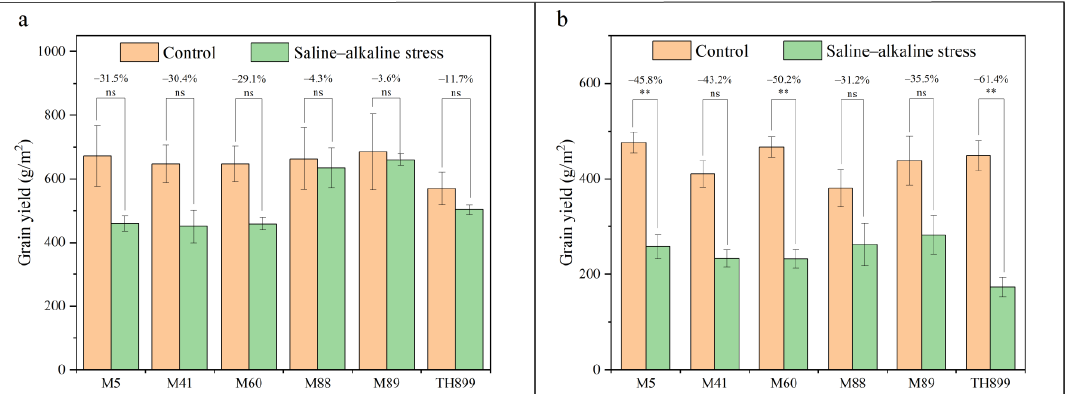
Figure 4. Grain yield of mutant lines and the parent TH899 under saline–alkaline stress and control condi- tions in 2019 ( a ) and 2020 ( b ). Bars are the means and standard errors of three ( a ) and four ( b ) replications. ** indicates significant differences at p < 0.01; and ns indicates no significant differences. The values on top of the bars indicate the decrease in grain yield under saline–alkaline stress relative to the control. In 2019, the ANOVA of the yield components of the mutant lines and TH899 under saline–alkaline stress revealed significant differences in SP and 1000-GW between the mutant lines and TH899. The SP and the 1000-GW were higher in mutant lines compared with TH899 (Table 4). In 2020, ANOVA of the yield components of the mutant lines and TH899 under saline–alkaline stress revealed significant differences in PH, PL, and 1000-GW between the mutant lines and TH899. The PH was shorter (84.8 cm to 95.0 cm), the PL was longer (17.5 cm to 19.8 cm), and the 1000-GW was higher (22.02 g to 25.30 g) in mutant lines compared with TH899 (Table